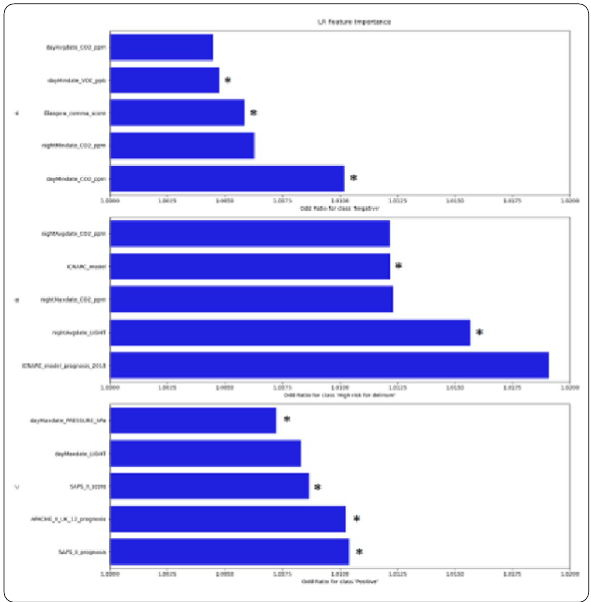
Conclusion: Severity scores including Glasgow coma score, SAPS II score and its prognosis score, ICNARC model and APACHE II UK 12 prognosis score should be considered as key clinical variables when predicting patient’s delirium outcomes. Liberation from HFNC and invasive ventilator for AICU patients should be actively encour- aged since they could significantly increase the risk of delirium. This research is also the first study to suggest air quality such as radon gas level and air pressure have an impact on delirium